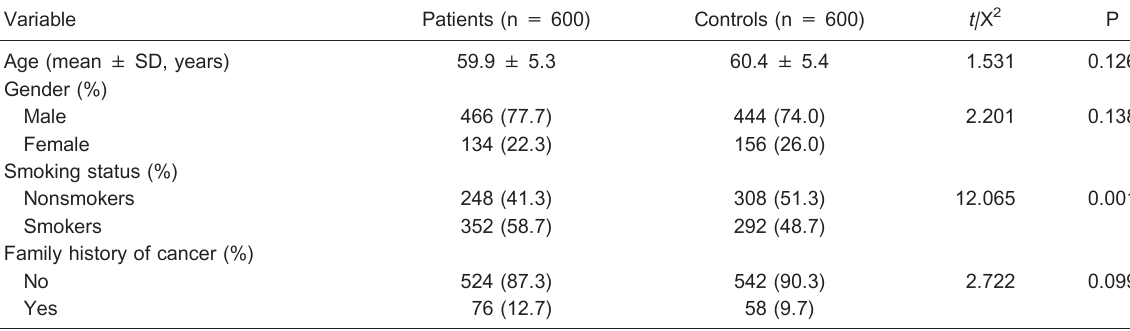
Table 1. Comparison of the basic characteristics of the patient and control groups.